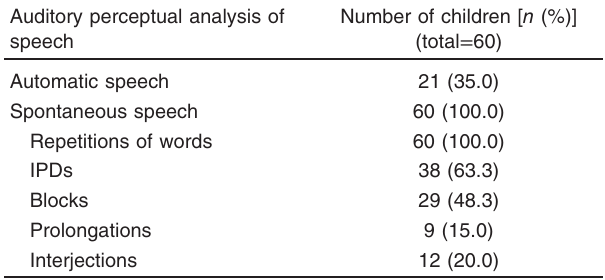
Table 4 Analysis of the auditory perceptual analysis of the automatic and spontaneous speech of participating children Auditory perceptual analysis of